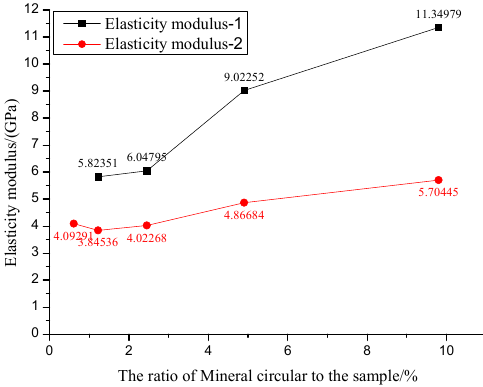
Figure 25. Mean value of elastic modulus for different mineral proportions.